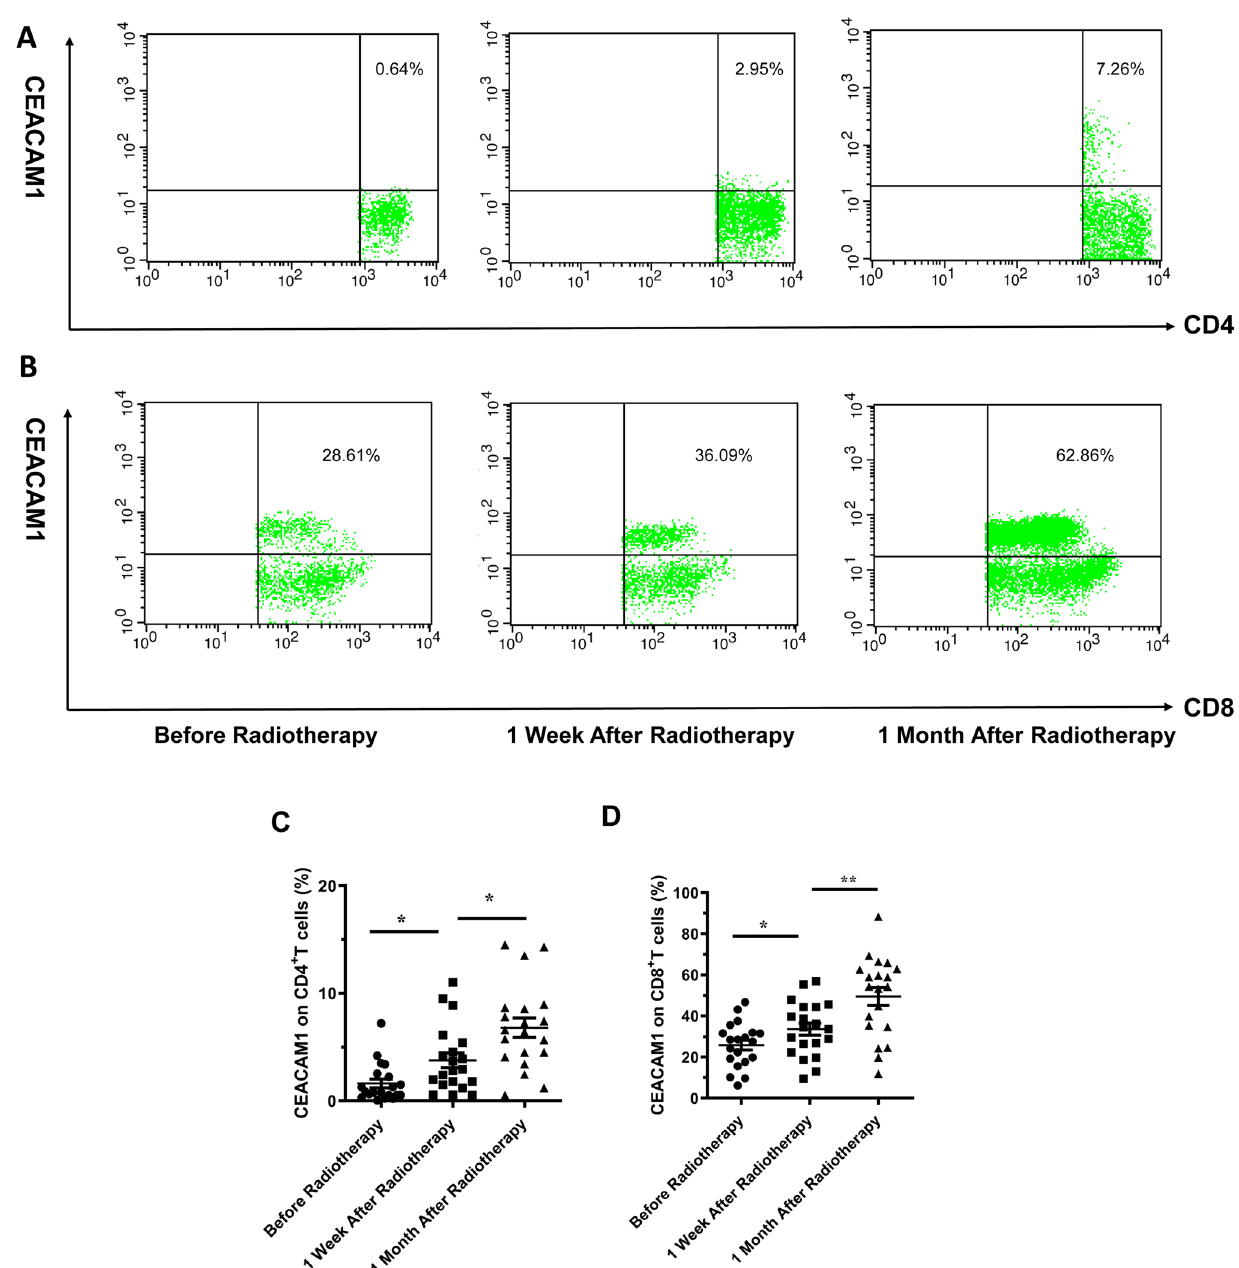
Fig. 1 Expression of CEACAM1 on T-lymphocytes in the peripheral blood of postoperative patients with glioma before and after radiother- apy. A , B Flow-cytometric graphs of the expression of CEACAM1 on CD4 + and CD8 + T-lymphocytes in the peripheral blood of patients with postoperative glioma before and after radiotherapy. C Statistical graph of the percentage of CEACAM1 + CD4 + T-cells. D Statistical graph of the percentage of CEACAM1 + CD8 + T-cells. *: P < 0.05, **: P <